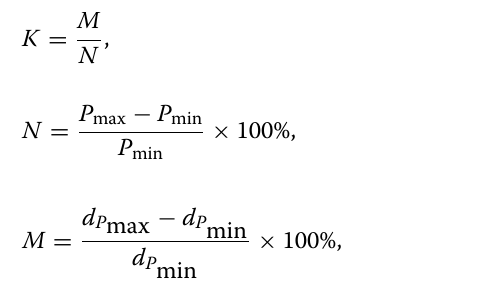
Figure 10 The extrusion working principle and 3D